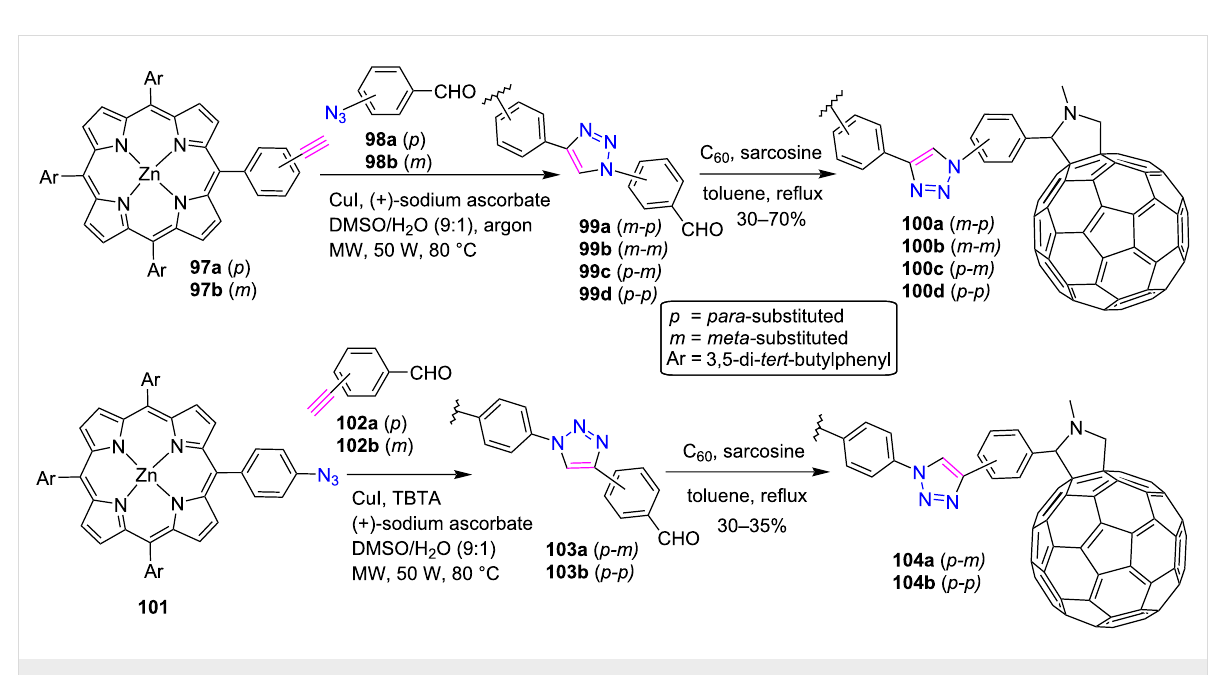
Scheme 20: Synthesis of meso -triazole-linked porphyrin-fullerene dyads 100a–d and 104a , b